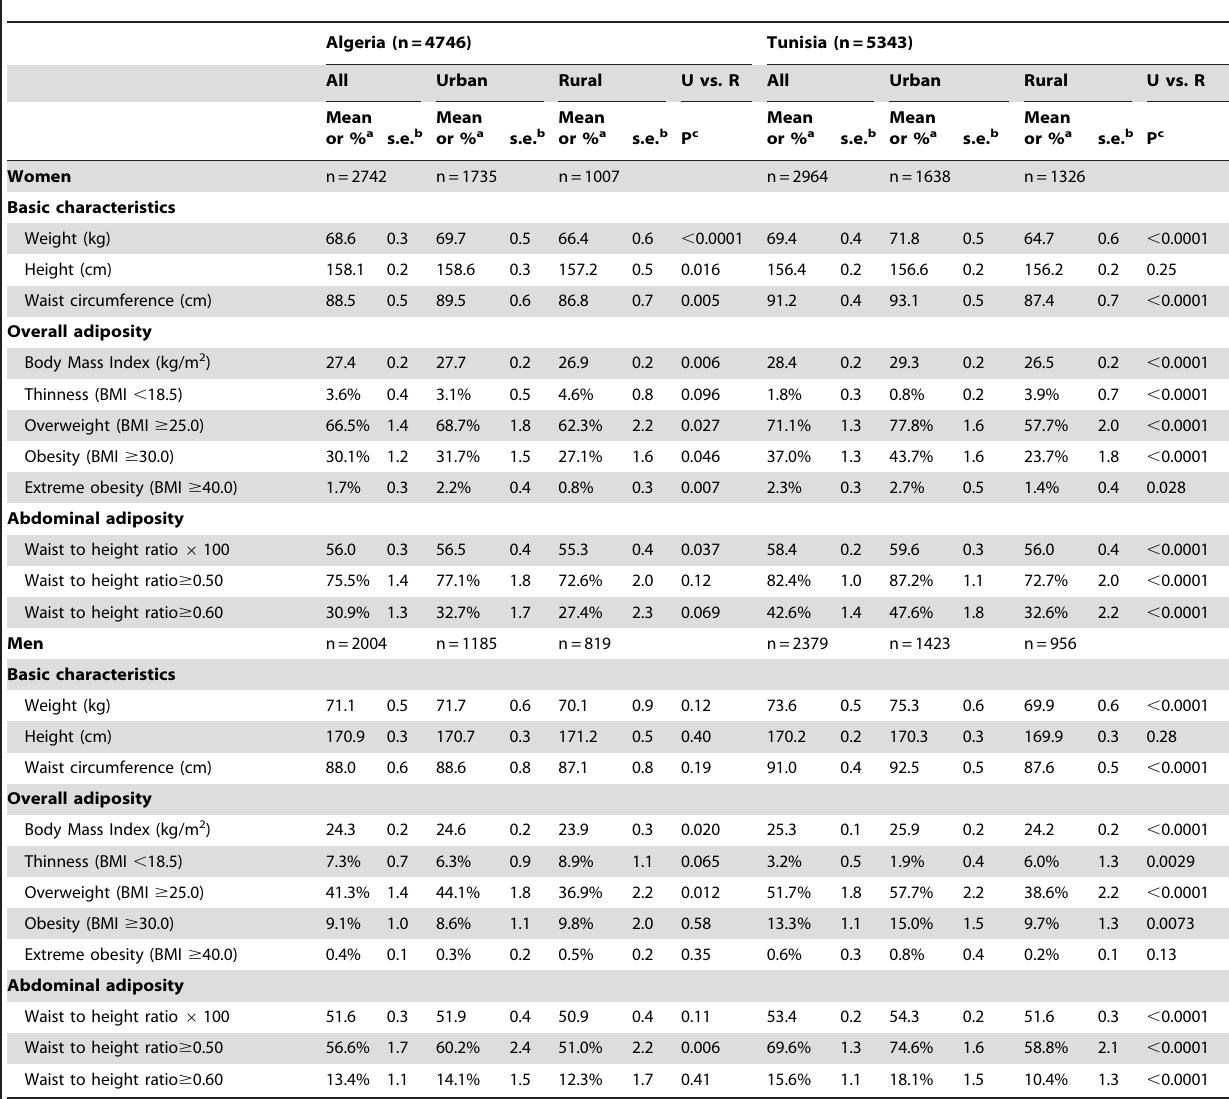
Table 2. Anthropometric characteristics of 35–70 year old Algerian and Tunisian adults by gender and